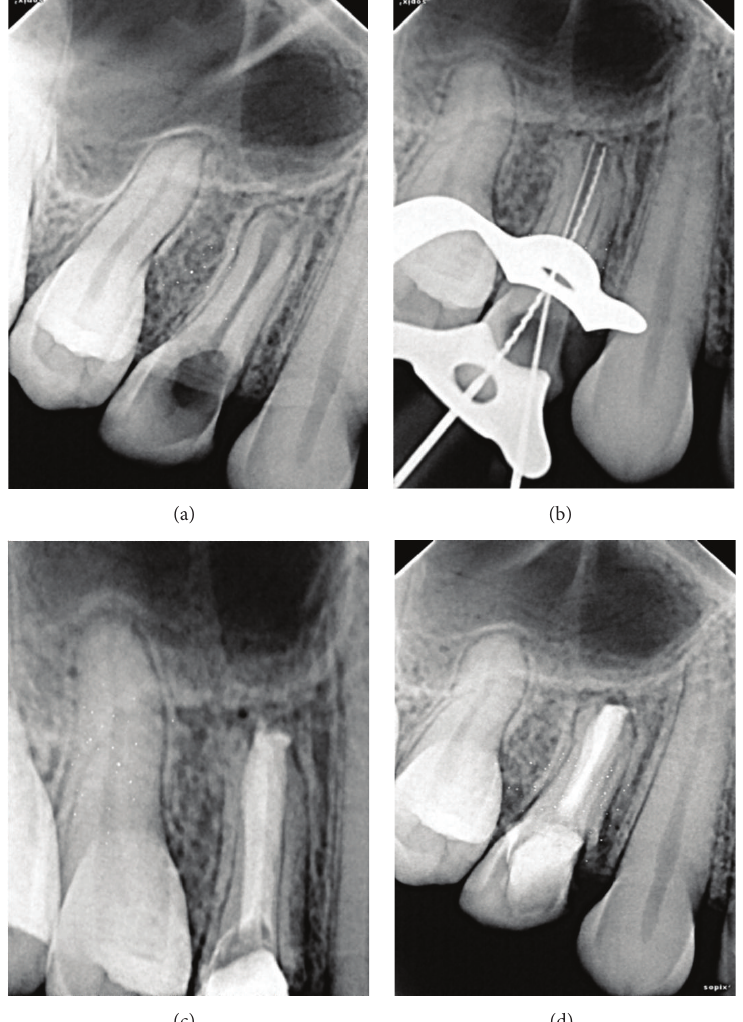
Figure 1: (a) Preoperative radiograph (Case 1). (b) Working length radiograph (Case 1). (c) MTA obturation (Case 1). (d) One-year follow-up radiograph (Case